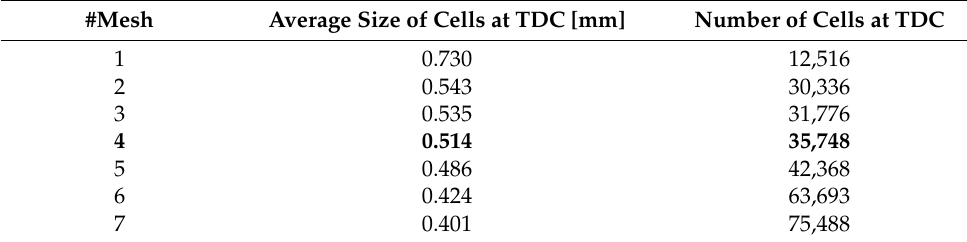
Table 6. Mesh characteristics.